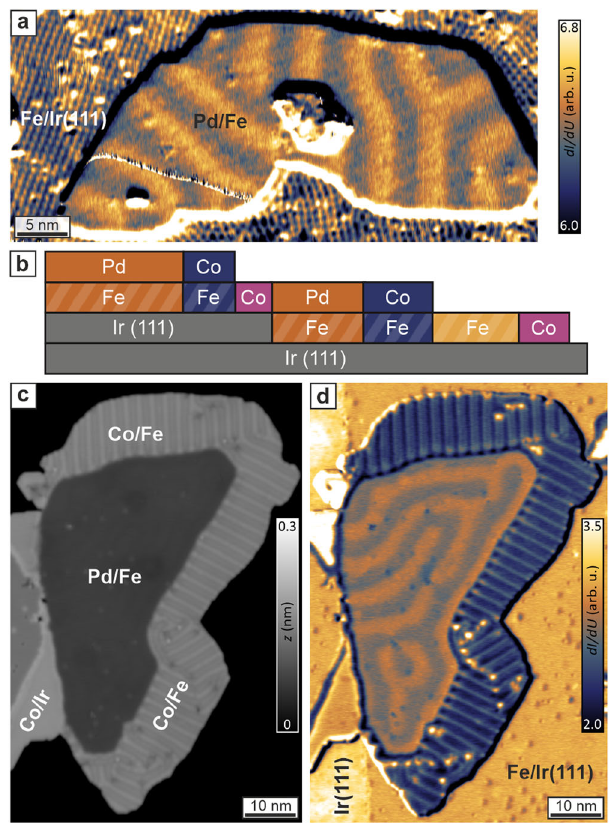
Fig. 1 The Pd/Fe/Ir(111) system with Co/Fe-decorated edges.